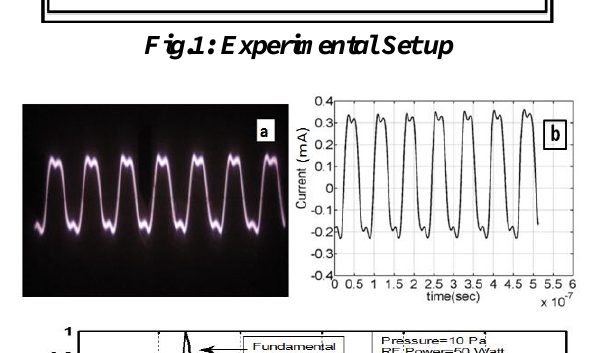
Fig.1: Experimental Set up